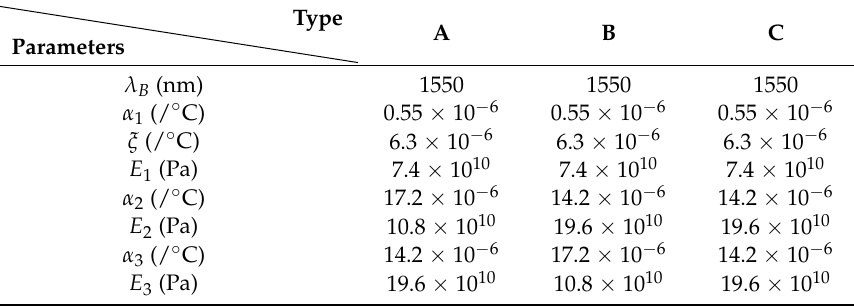
Table 1. Parameters of the stepped-metal coated-fiber Bragg grating (SMC-FBGs). Type Parameters